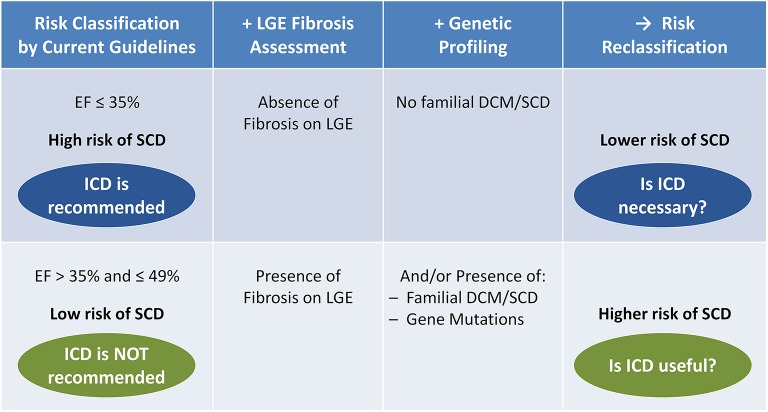
Potential reclassification of the risk of sudden cardiac death (SCD) by late gadolinium enhancement (LGE) fibrosis assessment combined with clinical and molecular genetic profiling, in patients with dilated cardiomyopathy (DCM) and heart failure (NYHA class II-III), under optimal medical therapy for at least 3 months, and with life expectancy >1 year. Among patients with severely depressed left ventricular function [ejection fraction (EF) ≤ 35%], a negative LGE test (absence of fibrosis) combined with the absence of familial DCM/SCD may identify a subgroup of patients at lower risk of SCD, in which implantable cardioverter-defibrillator (ICD) may be not necessary (blue). Among patients with moderately depressed left ventricular function (EF > 35% and ≤ 49%), a positive LGE test (presence of fibrosis) and/or the presence of familial DCM/SCD or pathological gene mutations may identify a subgroup at higher risk of SCD, in which ICD may be useful (green).